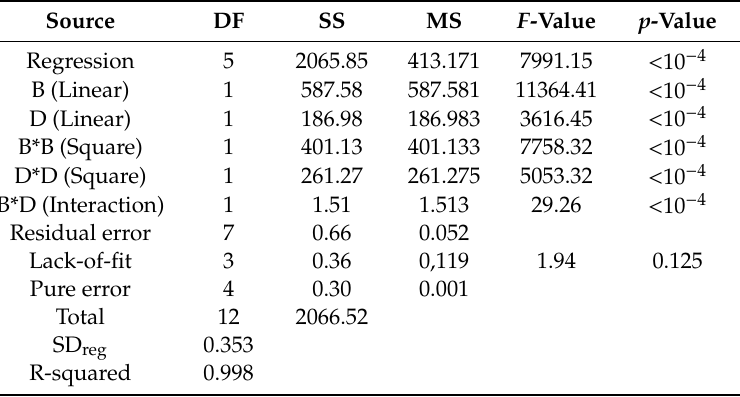
Table 6. ANOVA of regression model for extraction of Cd(II); B: Aliquat 366 (mM); D: EDTA (mM); DF: degrees of freedom; SS: sum of squares; MS: mean square.